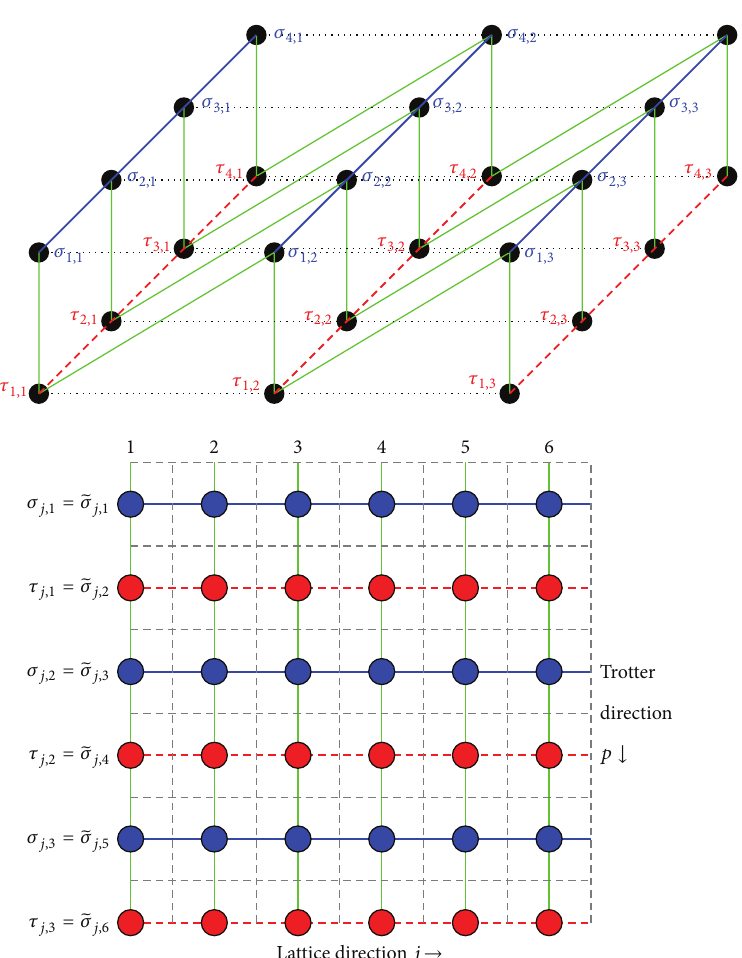
Figure 2: Lattice representation of a class of classical systems equivalent to the class of quantum systems (9). The blue (thick solid) lines represent interactions with coefficients dictated by 𝐽 𝜎 𝑗 and the red (thick dashed) lines by 𝐽 𝜏 𝑗 , and the 𝐽 𝑗 coupling constants correspond to the green (thin solid) lines which connect these two lattice interaction planes.